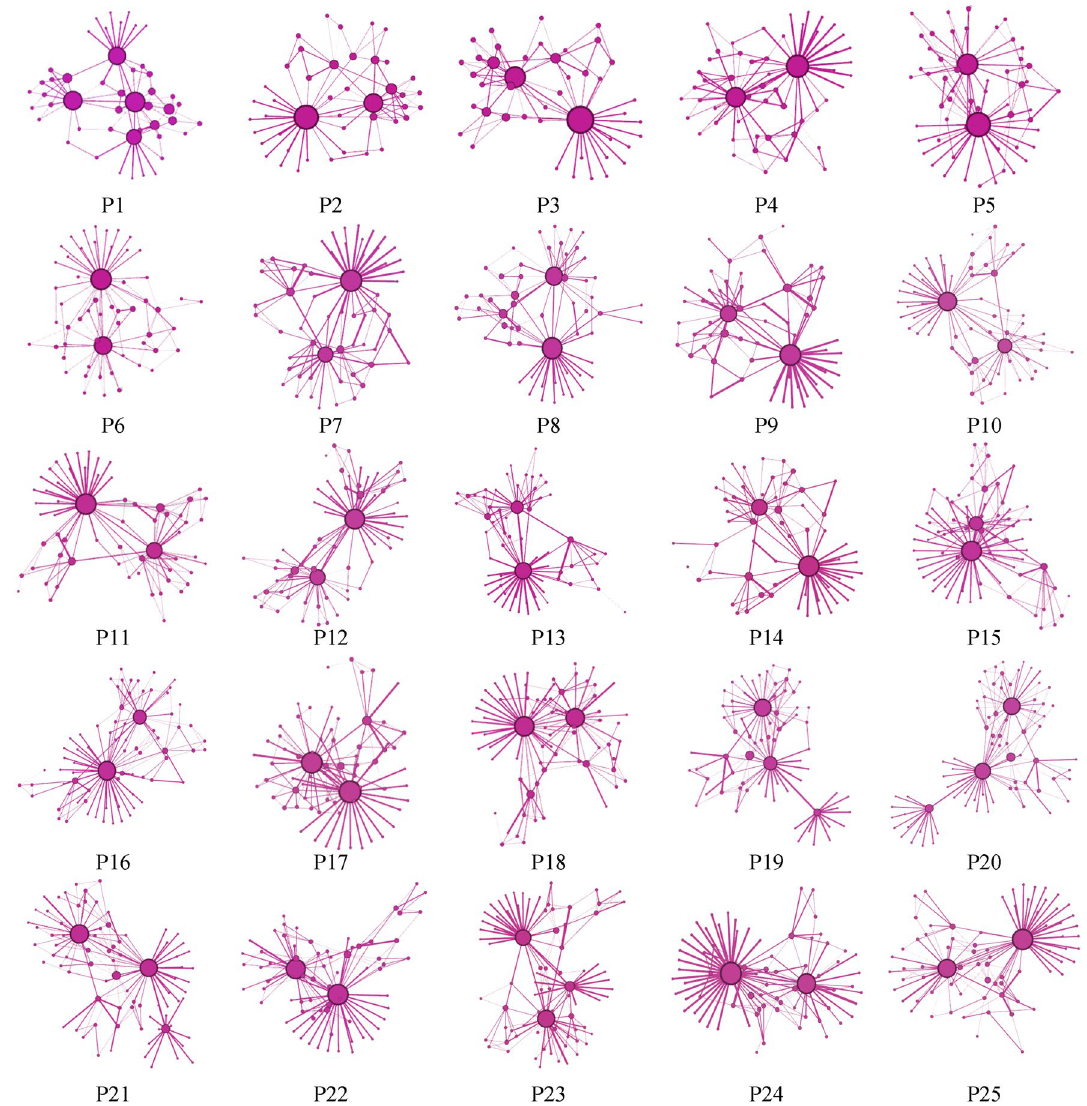
Figure 7. Product structural networks of the 25 generations of smartphones.